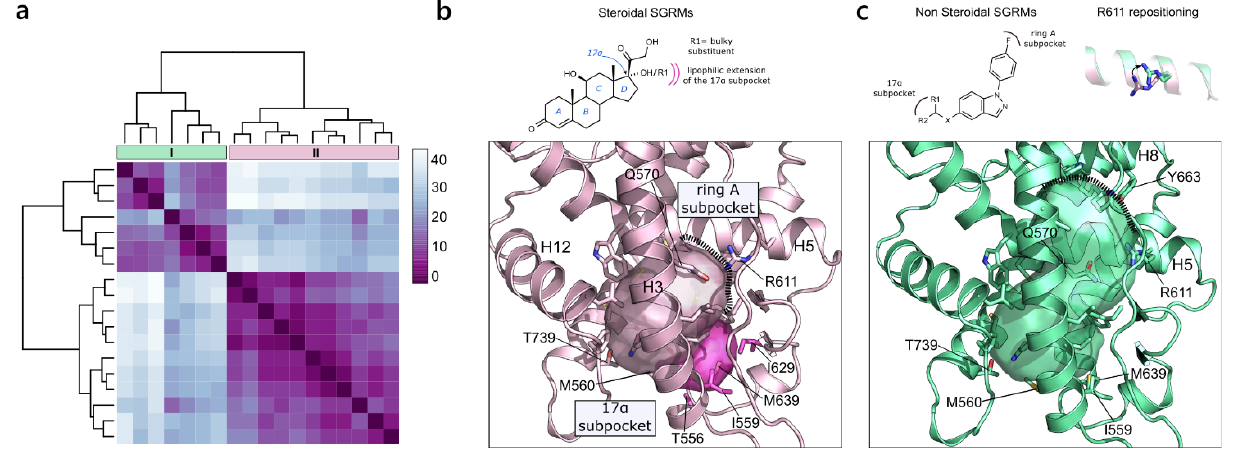
Figure 5. GR variability. ( a ) Heatmap of the hierarchical clustering of GR. ( b ) On the bottom, the representation of the pocket from cluster II (PDB ID 4UDC) is shown. A small extension of the canonical pocket is highlighted in magenta (PDB ID 4UDD). On top, the chemical structure of the endogenous ligand, cortisol, is shown, indicating the position for the modulation of steroidal SGRMs. ( c ) Representation of the extended pocket from cluster I (PDB ID 4CSJ). On the top, the general chemical structure of non-steroidal SGRMs and the flipping of R611, enabling the extension of the binding site, are shown.